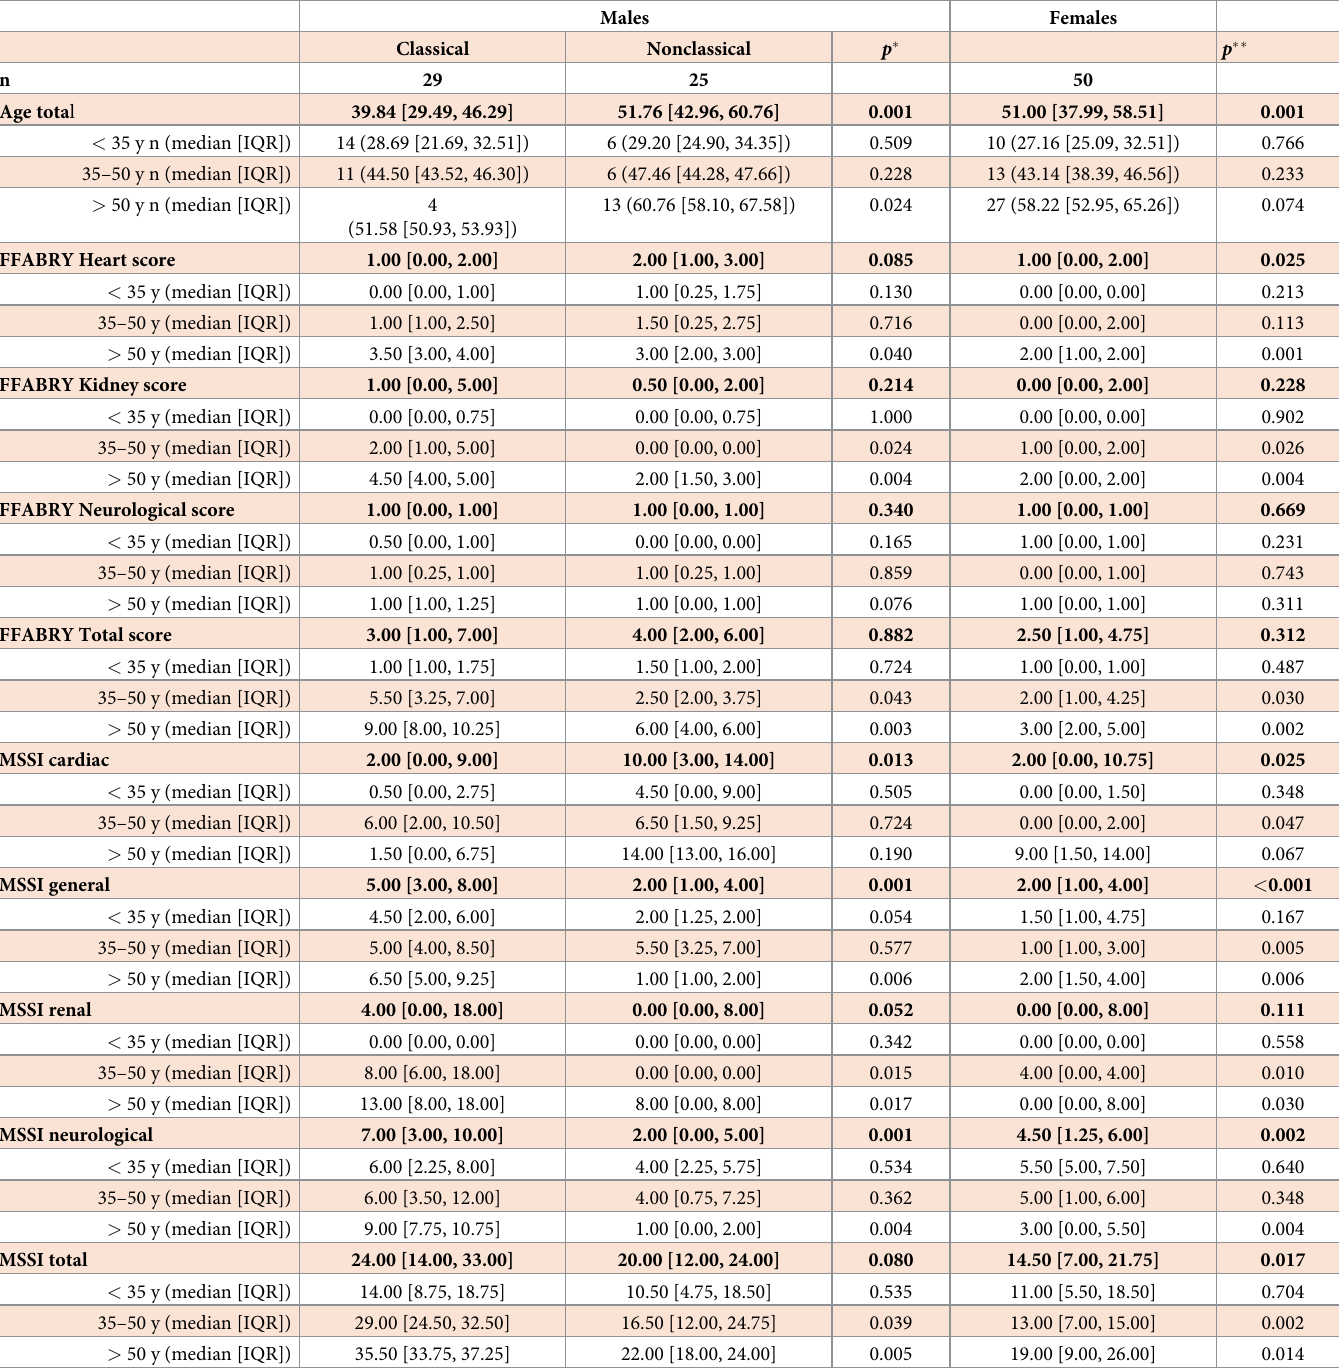
Table 3. FFABRY and MSSI scores (comparison with Mann-Whitney test p � : Classical versus nonclassical males; p �� : Males versus females).